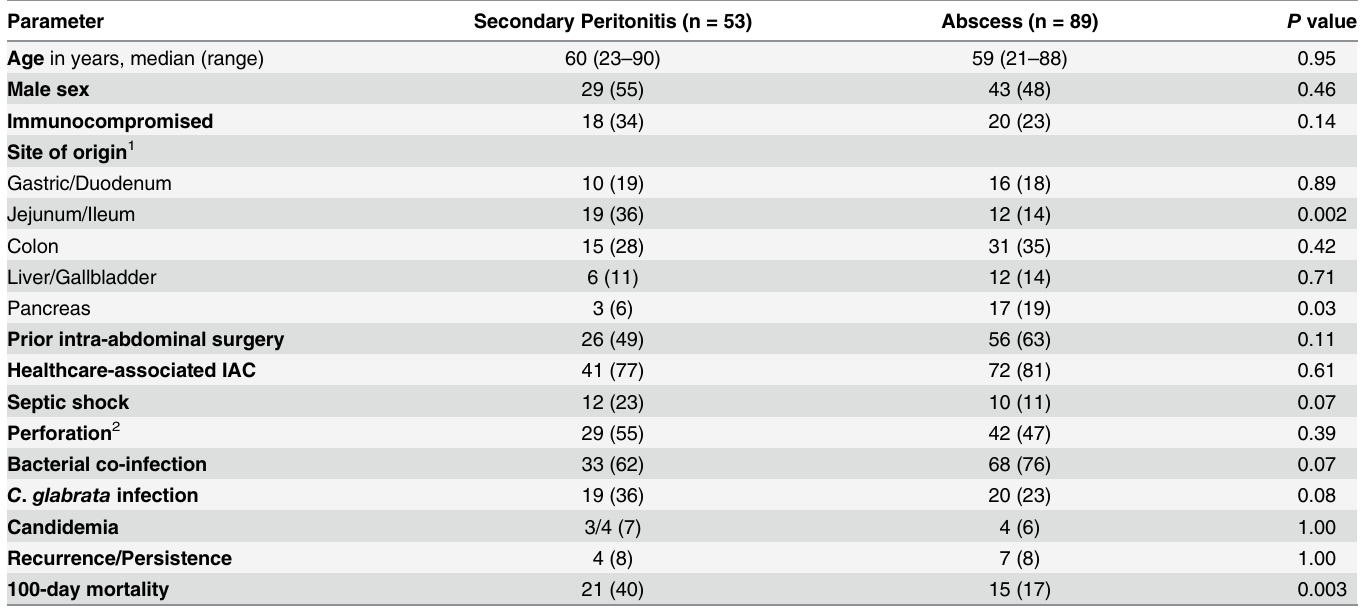
Table 3. Comparison of clinical characteristics between patients with secondary peritonitis and intra-abdominal